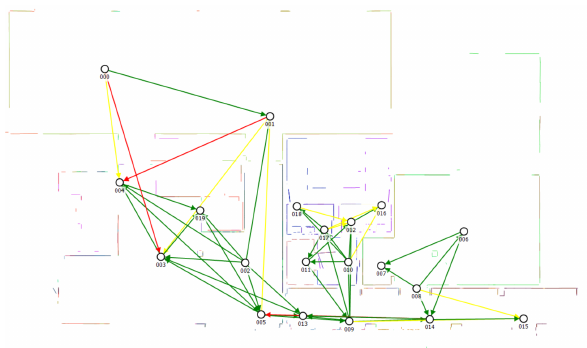
Figure 2. Observation-Topology and connections of the scans in Scantra with cross-section of the point cloud in the background Red lines must be checked to exclude gross errors. For example, reflections in glass or in long corridors can lead to incorrect connections. A good network configuration is also important to achieve redundancy and stability. A block adjustment optimizes the relative location and orientation of all laser scans based on redundantly captured areas. After that, all relative transform- ation parameters are adjusted and controlled. This allows the scans to be transformed into the system from one (any)